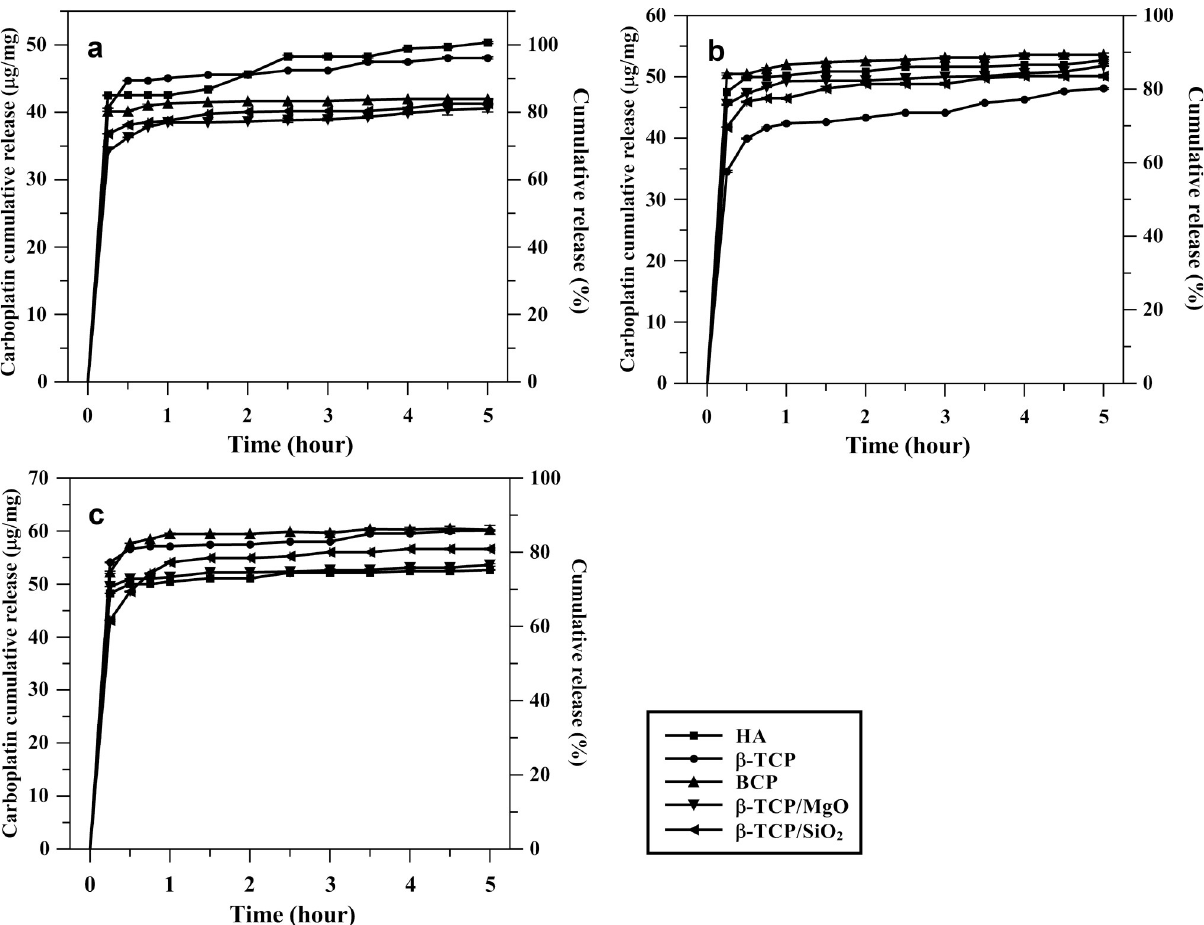
Fig 8. Cumulative carboplatin release from biomaterials carboplatin-load in three different initial concentration. (a) 50 mg/g; (b) 60 mg/g; (c) 70 mg/g.